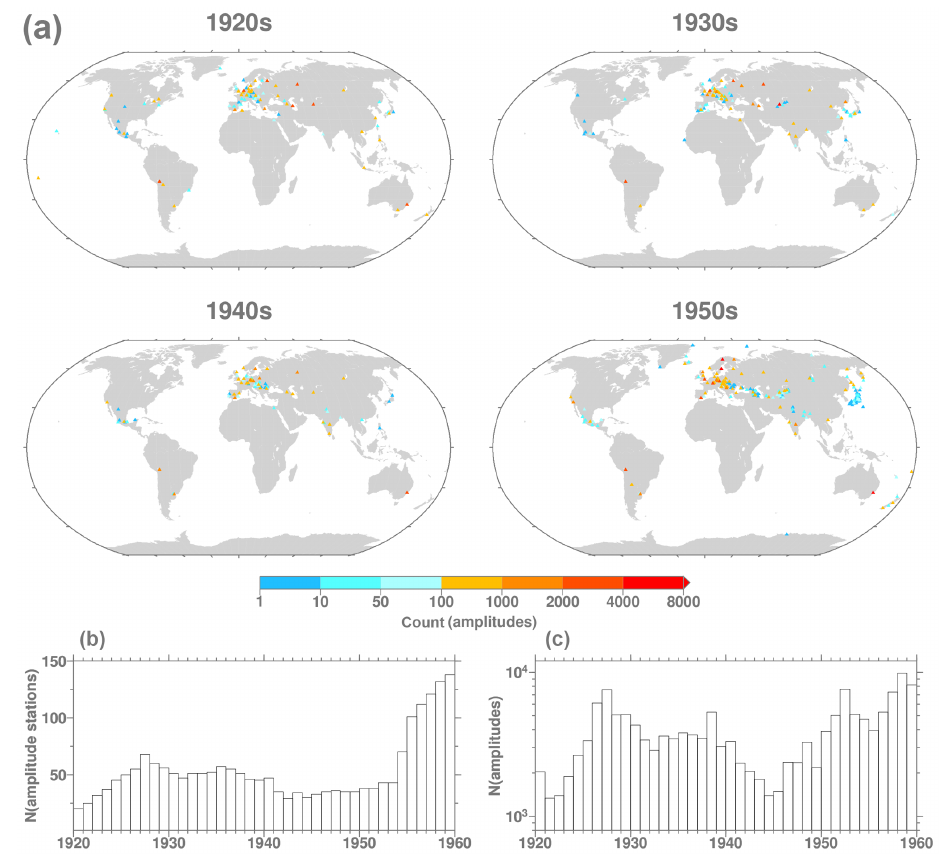
Figure 4. Distribution of the stations in each decade contributing amplitudes to the extension events and colour-coded by number of ampli- tudes. The annual number of stations (b) and amplitudes (c) are also summarised.